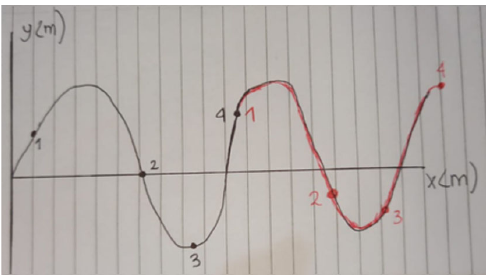
FIG. 9. Student ’ s difficulty to place the displacement of points on the new wave